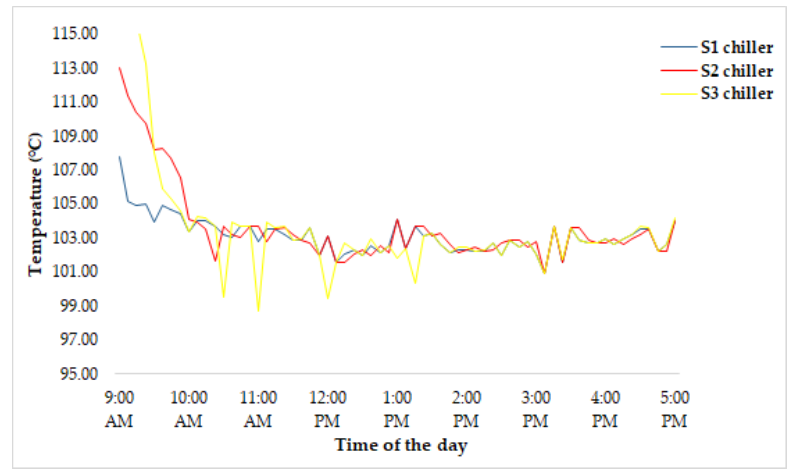
Figure 14. Outlet temperature profiles for all flow schemes at chiller’s